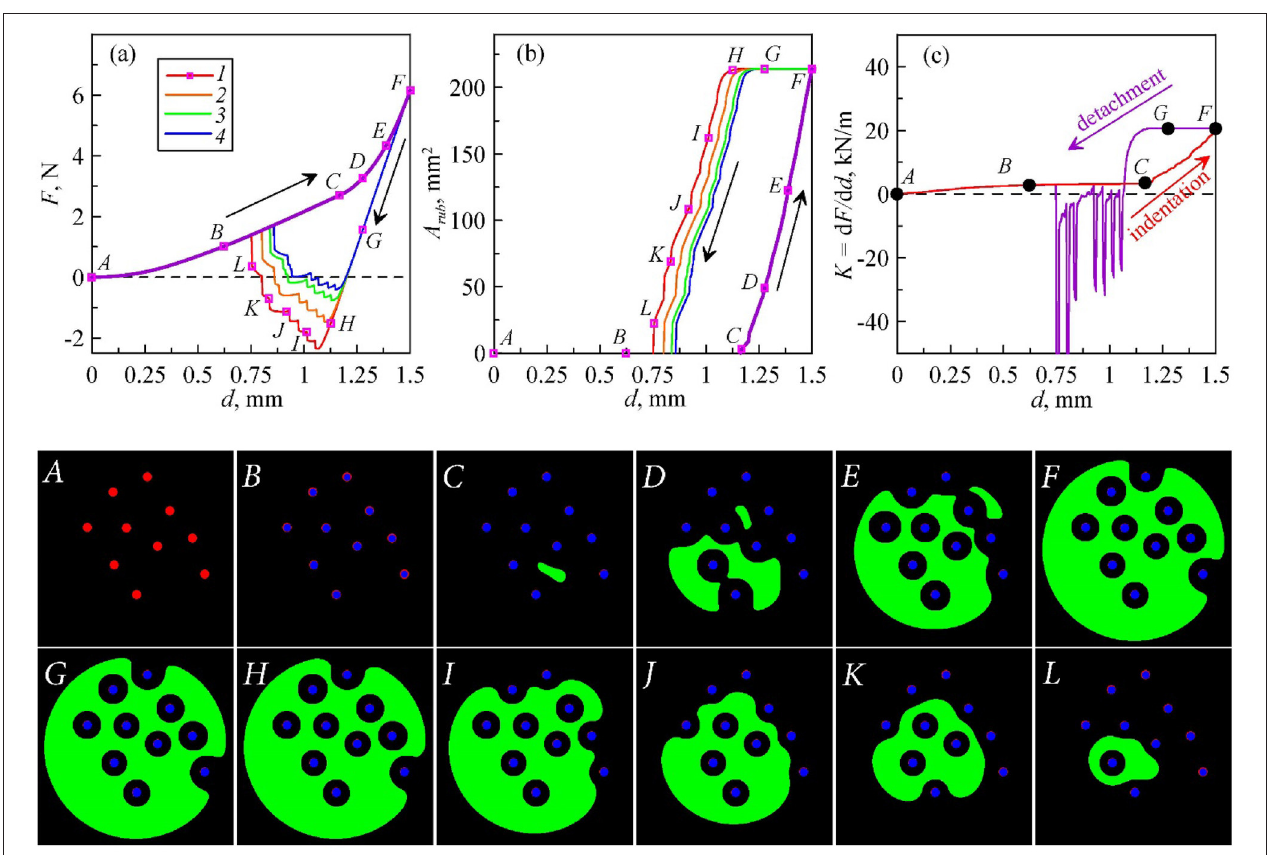
FIGURE 9 | Simulation of adhesive contact between a spherical indenter and elastomer sheet with 10 identical micro particles. Dependencies of normal force (a) , direct contact area (b) , and contact stiffness (c) on indentation depth. Images below show evolution of contact zones in different colors: black—noncontact area without particles; red—noncontact area where particles located; blue—area of contact between elastomer and particles (asperities on the indenter surface); green—area of direct contact between elastomer and indenter.